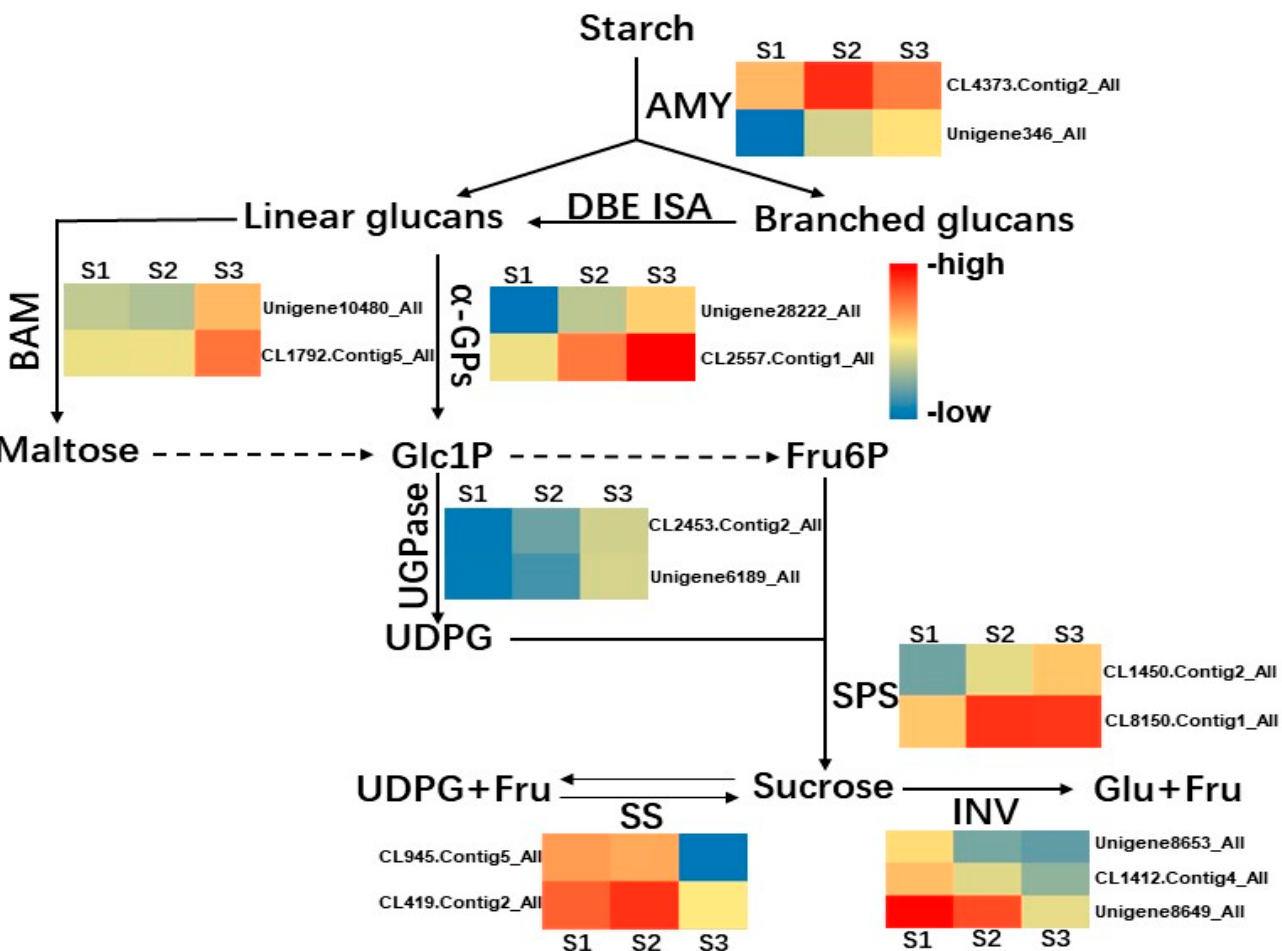
Figure 9 . Expression of profiles of unigenes associated with starch and sucrose metabolism. AMY, alpha amylase (EC 3.2.1.1); BAM, beta-amylase (EC 3.2.1.2); α -GPs, α -glucan phosphorylase (EC 2.4.1.1); UGPase, UDP-glucose pyrophosphorylase (EC 2.7.7.9); SPS, sucrose phosphate synthase (EC 2.4.1.14); SS, sucrose synthase (EC 2.4.1.13); INV, invertase (EC 3.2.1.26); Glc1P, glucose 1-phosphate; Fru6P, fructose 6-phosphate; UDPG, UDP-glucose; Fru, fructose; Glu, glucose. Red indicates high expression level and blue indicates low expression level.